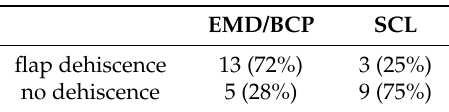
Figure 3. Soft tissue healing two weeks after surgery (EMD/BCP group): ( A ) EHI 1 and closed flap; ( B ) EHI 5 and flap dehiscence. EMD/BCP: enamel matrix derivative/biphasic calcium phosphate; EHI: early healing index. Table 3. Contingency table for flap dehiscences (yes/no) noted two weeks after surgery. Significant difference favouring the SCL group ( p = 0.024, Pearson’s Chi 2 test). EMD/BCP: enamel matrix derivative/biphasic calcium phosphate; SCL: surgical crown lengthening.